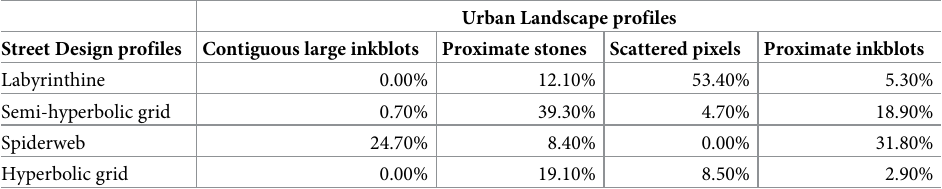
Table 4. Overlap among urban landscape and street design